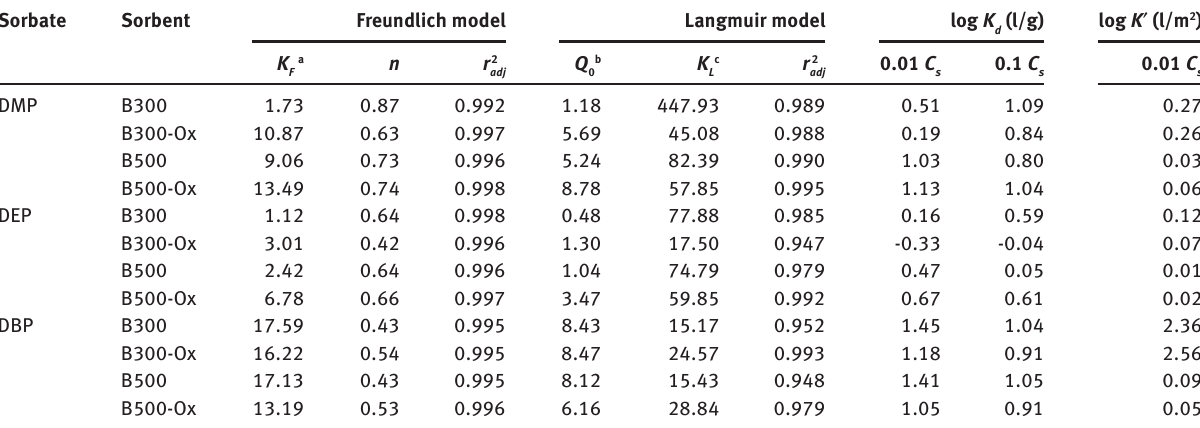
Table 3: Fitting results of adsorption of dimethyl phthalate (DMP), diethyl phthalate (DEP) and dibutyl phthalate (DBP) on biochars based on Freundlich and Langmuir model.